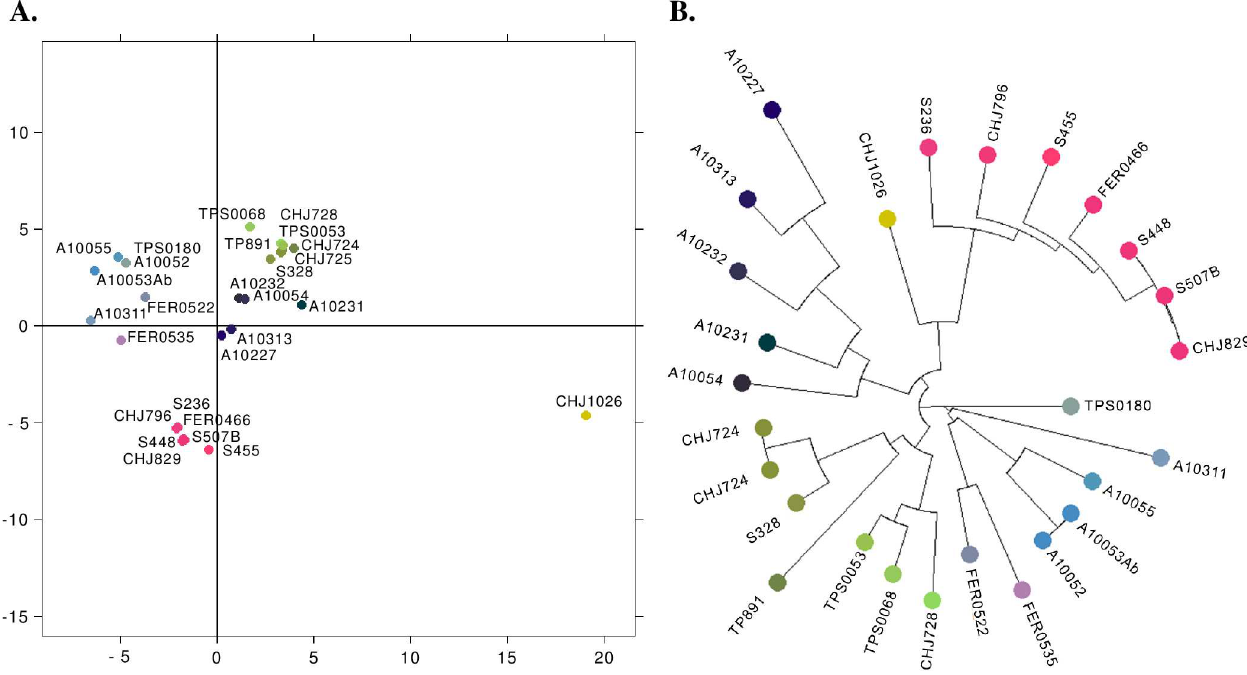
Fig 4. Discriminant Analysis of Principal component analysis (DAPCA) and Neighbor Joining Tree for the nuclear TcI lineage from Guatemala and El Salvador. A) Discriminant Analysis of Principal Component, B) Neighbor-Joining Tree inferred from the PCA distances.